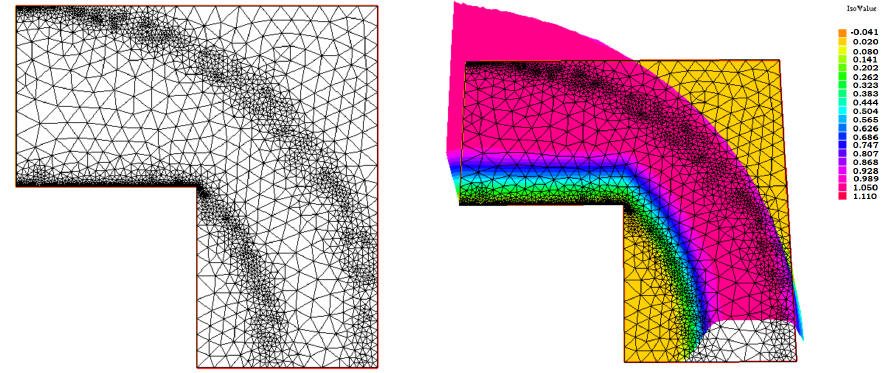
Figure 10. Adapted meshes for example 2 and residual-based error estimator. ( Left ) The mesh at the final stage. ( Right ) A 3D plot of the computed solution with the final